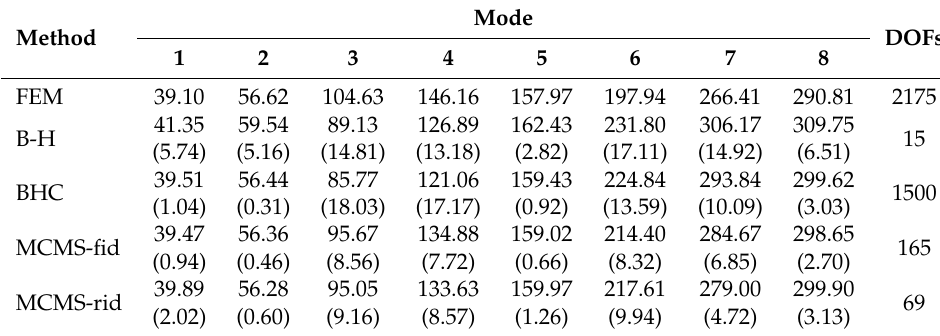
Table 1. The first eight natural frequencies of the beam f (Hz) and relative error e (%).